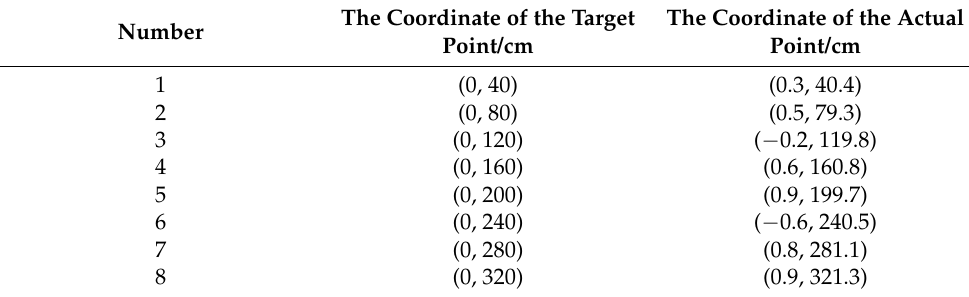
Table 3. Experiment data of setpoint parking in the laboratory.